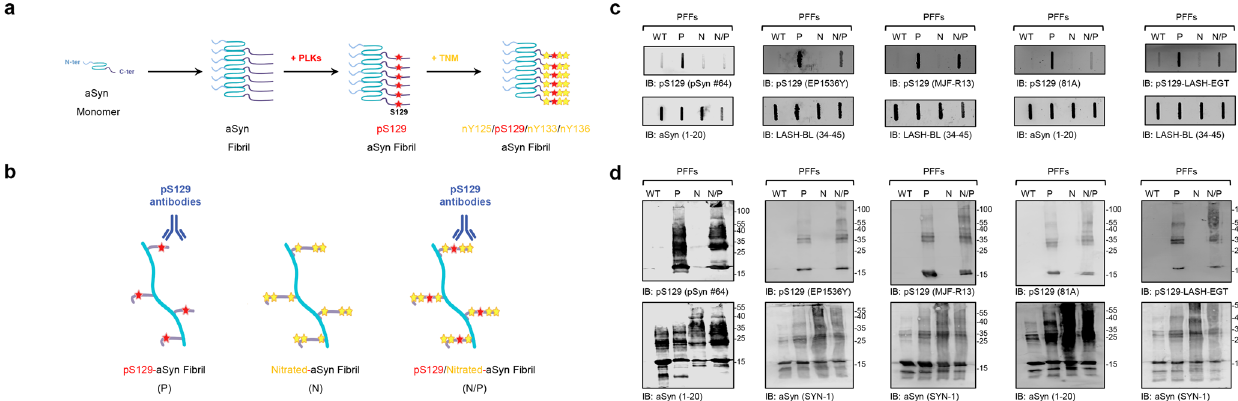
Fig. 3 Nitration of aSyn does not impair the capacity of pS129 antibodies to detect pS129 fi brils. a Preparation of aSyn fi brils carrying both phosphorylation and nitration modi fi cations. aSyn fi brils were fi rst site-speci fi cally phosphorylated at S129 residue by being incubated with PLK3. Afterwards, TNM was added to induce the nitration of the phosphorylated aSyn fi brils. b The capacity of aSyn fi brils site-speci fi cally phosphorylated at S129 and/or nitrated to be detected by the pS129 commercial antibodies (pSyn#64, MJF-R13, 81A, and EP1536Y) or the LASH-EGT homemade pS129 antibody was assessed by slot blot ( c ) and WB ( d ) analyses. a , b were created using BioRender.com. c , d Thirty-six nanograms of aSyn fi brils (PFFs) that were unmodi fi ed (WT), phosphorylated (P), nitrated (N), or nitrated/phosphorylated (N/P) were detected by slot blot ( c ) and WB ( d ) using pS129 antibodies (top panel) in combination with total aSyn antibodies (1 – 20 and 34 – 45, bottom panel). All blots were derived from the same experiment and were processed in